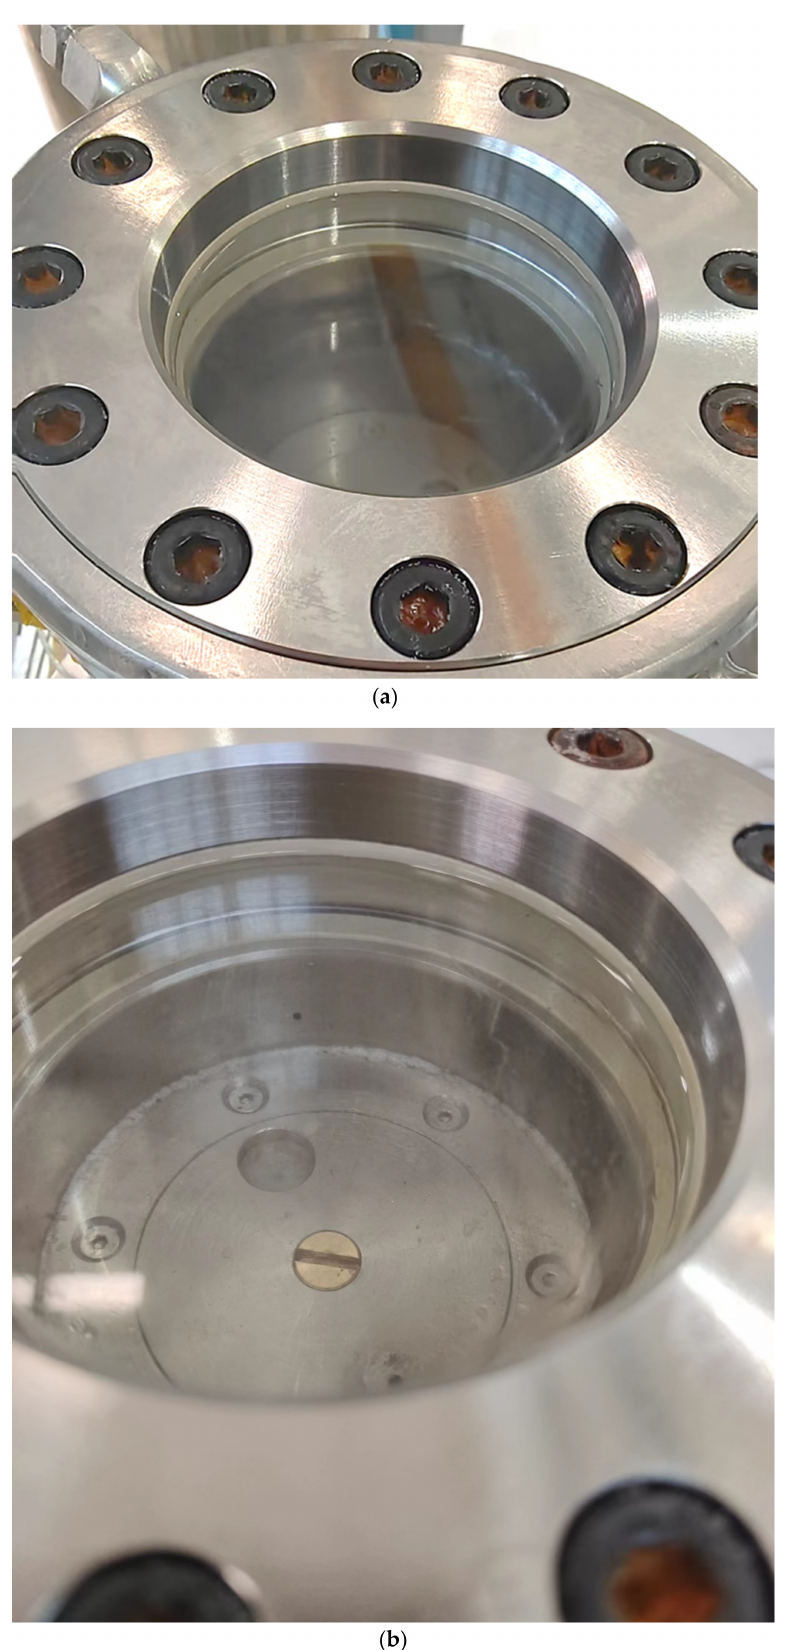
Figure 11. Comparison before and after piston rise: ( a ) piston in lowest position; and ( b ) piston rises to a certain